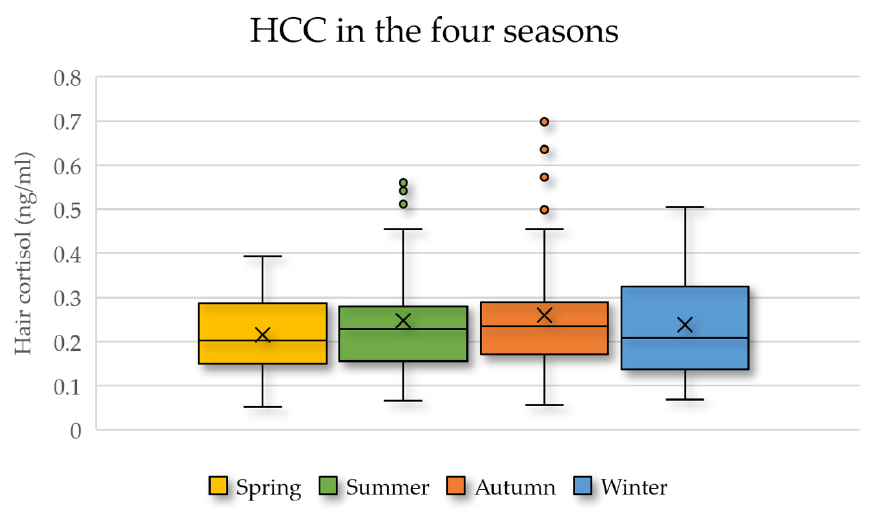
Figure 2. Box plot of the hair cortisol levels during the different seasons for all the included horses ( n = 47). ( n =